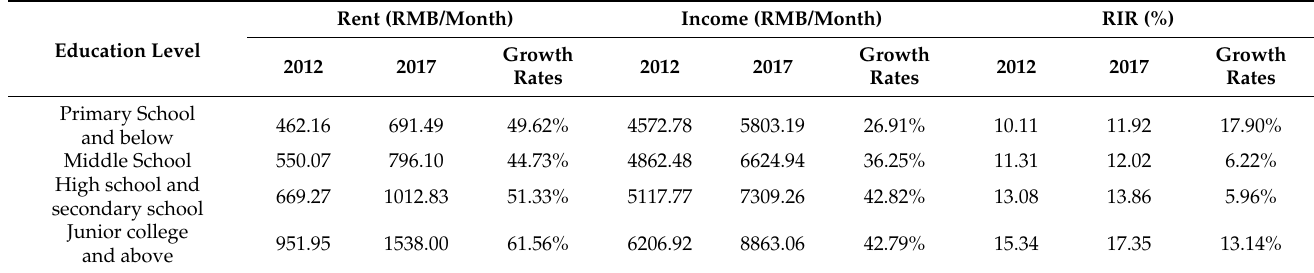
Table 1. Rent, income, and the RIR of groups with different educational levels, 2012 and 2017.